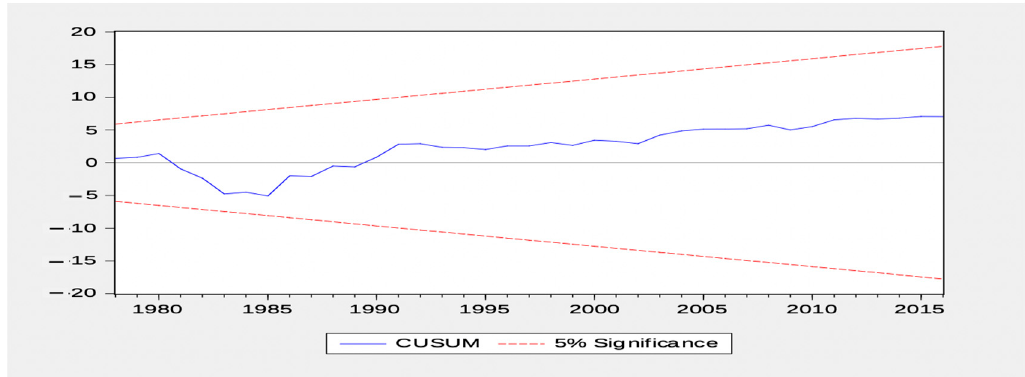
Figure A6. CUSUM Test (Saudi Arabia).